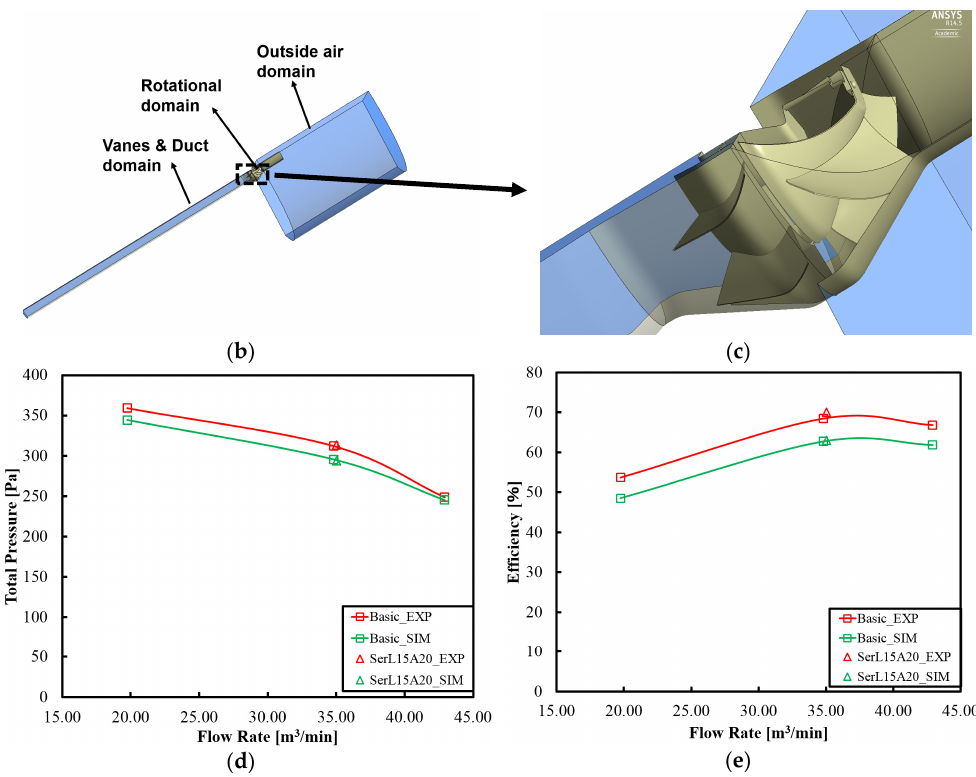
Figure 5. Validation of a 2-blade full-size model by results in our previous study [32]: ( a ) Experimental facilities, ( b ) Basic 2-blade full-size model, ( c ) Local details of the exaggerated region in ( b ), ( d ) Results of Total Pressure versus Flow Rate for the “Basic” and the “Serration L15A20” design derived from experiments (EXP) and simulations (SIM), ( e ) Results of Efficiency versus Flow Rate for the “Basic” and the “Serration L15A20” design derived from experiments (EXP) and simulations (SIM). The operating conditions of the serrations design in ( d ) and ( c ) and their nearby ‘basic ones’ are very close to that in Table 1.